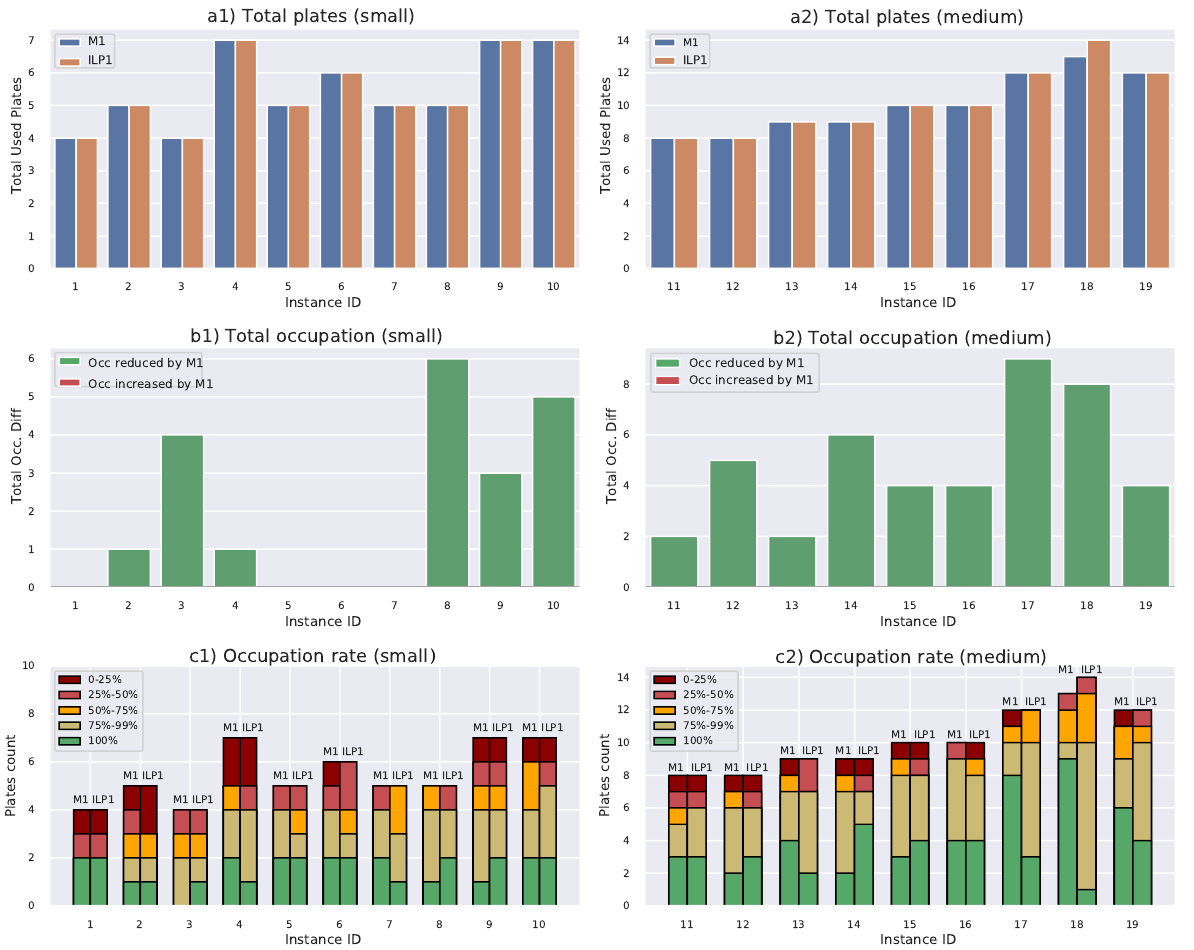
Results for M1 vs ILP1. Small and medium size files.